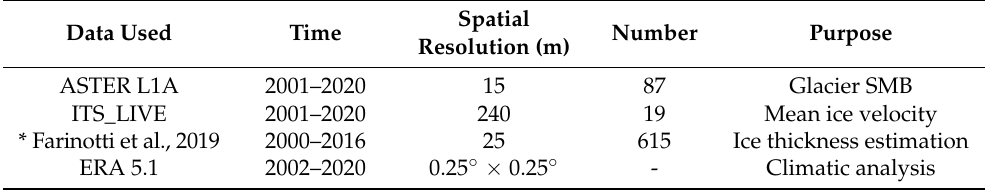
Spatial Number Purpose Resolution (m)